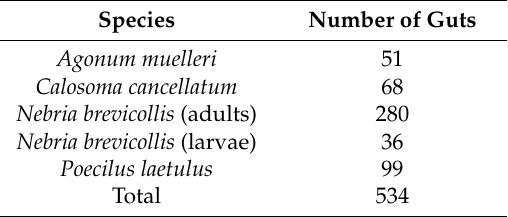
Table 2. Number of guts per carabid species from which DNA was extracted and that were screened for pest DNA using